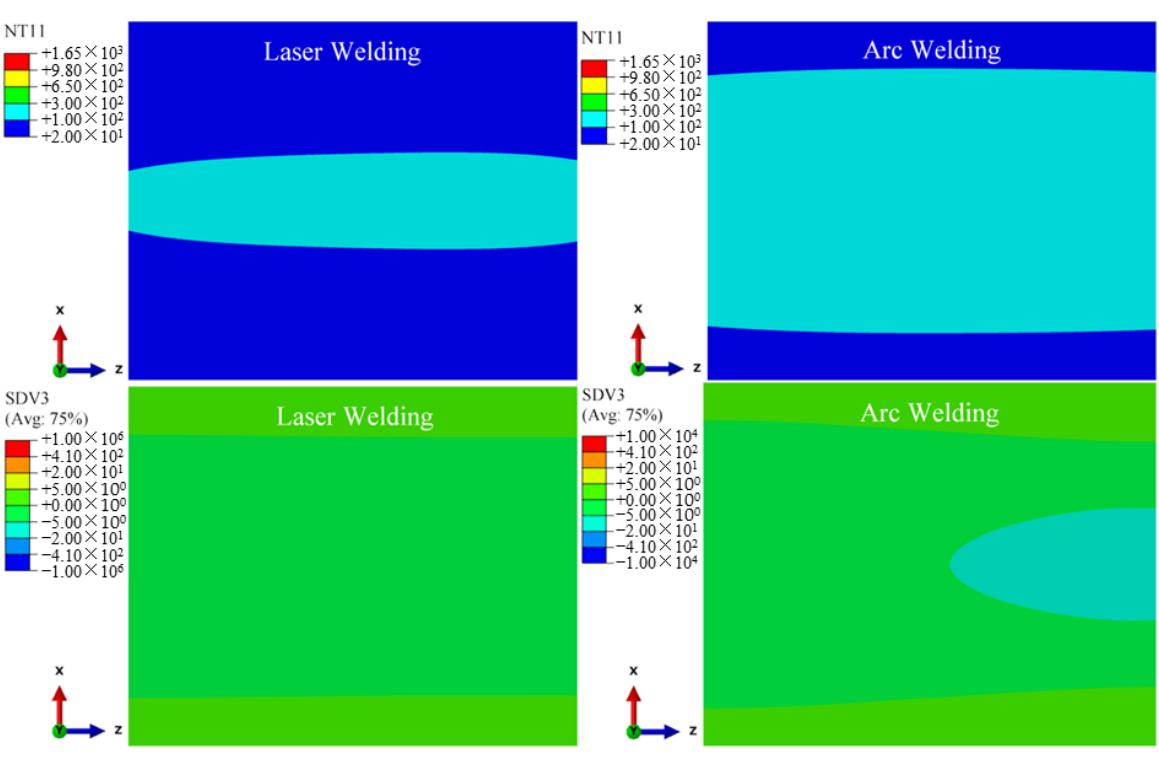
Figure 17. 60 s from start time, changes of current temperature NT11( °C ) and cooling/heating rate SDV3( °C /s) during welding.